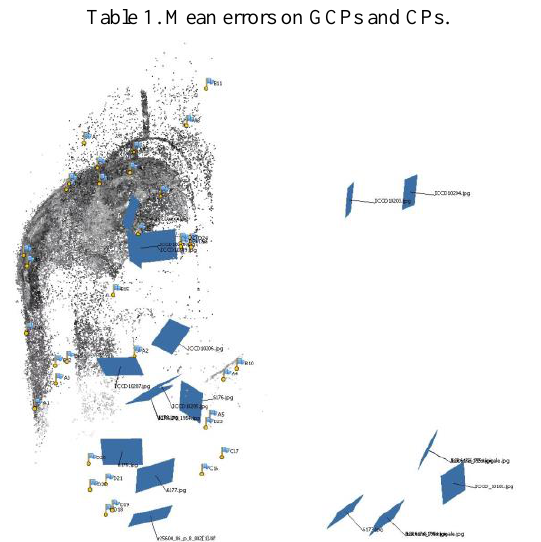
Figure 3. Image alignment and sparse cloud generated from historical images.